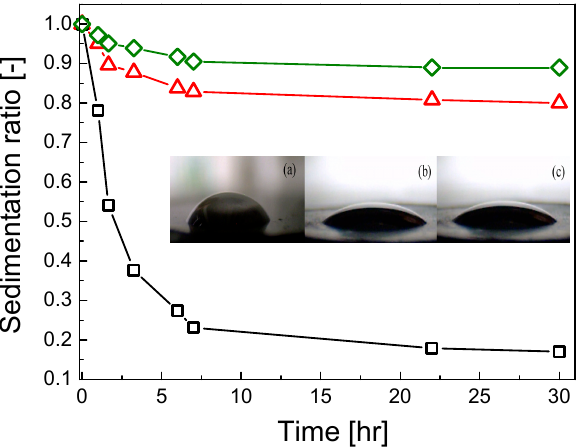
Figure 10. Sedimentation ratio as a function of time for 5 wt.% ER fluids consisting of original GO ( ), GO-PHEMATMS − 1 ( ), and GO-PHEMATMS-2 ( ) particles in silicone oil M200.